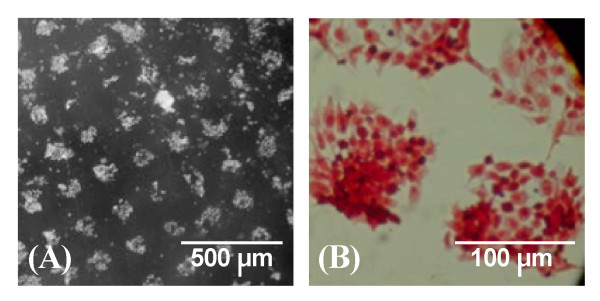
Micro-patterning of growth plate chondrocytes on a PPE:N-coated surface. Kapton® polyimide masks (100 μm openings, 200 μm pitch) were placed over the BOPP substrate to create the pattern. Growth plate chondrocytes grown on this patterned surface for 9 days and photomicrographs were taken (A). Proteoglycan production was visualized using Safranin-O staining (B).